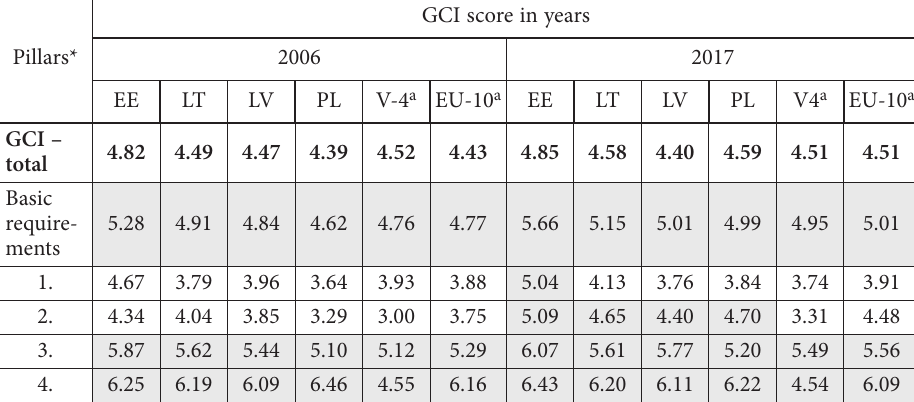
Table 5. Effects of specific factors on the competitive positions of the Baltic States (against the backdrop of Poland, the V4 countries and the EU-10) in 2006 and 2015 (source: Own calculations based on data as in Table 4)